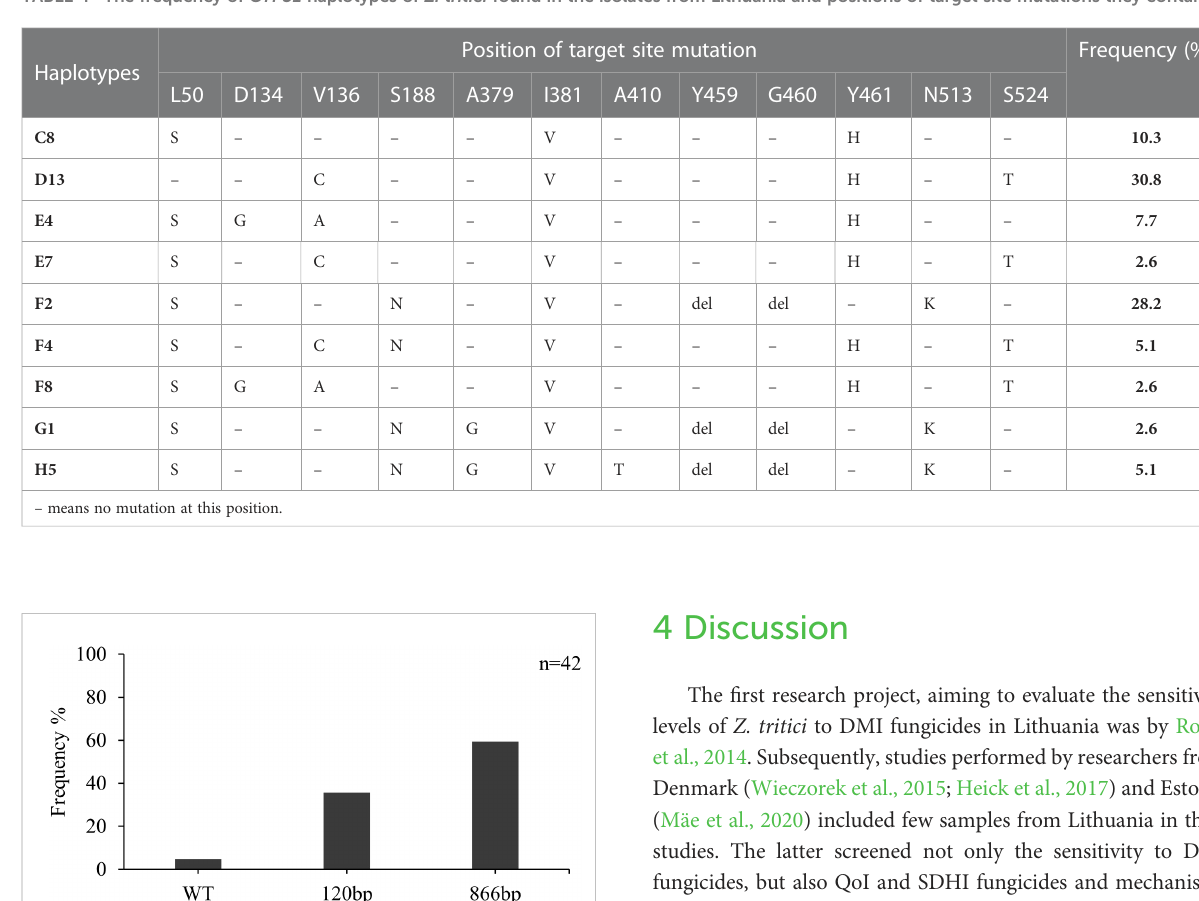
TABLE 4 The frequency of CYP51 haplotypes of Z. tritici found in the isolates from Lithuania and positions of target site mutations they contain.